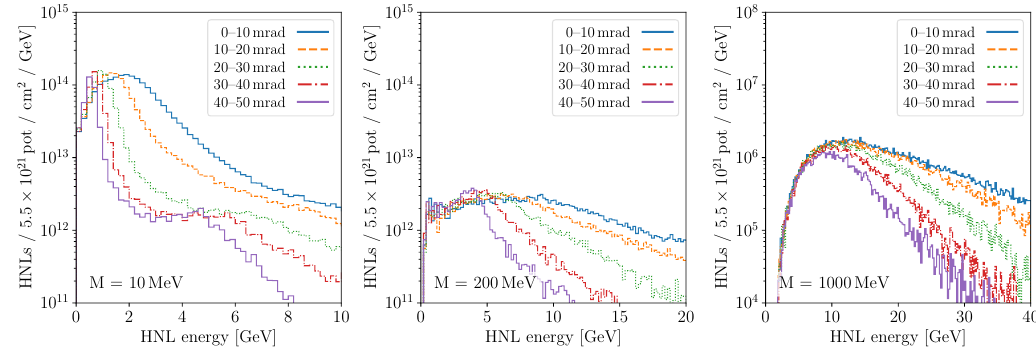
Figure 7 . The differential flux of HNLs at the DUNE near detector site ( 574 m baseline) for different HNL masses (left, middle, and right panels) and for different off-axis angles (different colors and line styles). For illustrative purposes, we have made the unphysical assumption | U | U µ 4 | 2 = | U τ 4 | 2 = 1 . In other words, we have assumed that all neutrino production processes in the DUNE/LBNF beamline are replaced by the corresponding HNL production processes. The fluxes shown here can therefore be linearly rescaled to smaller and more realistic values of | U the different vertical and horizontal axis scales in the three